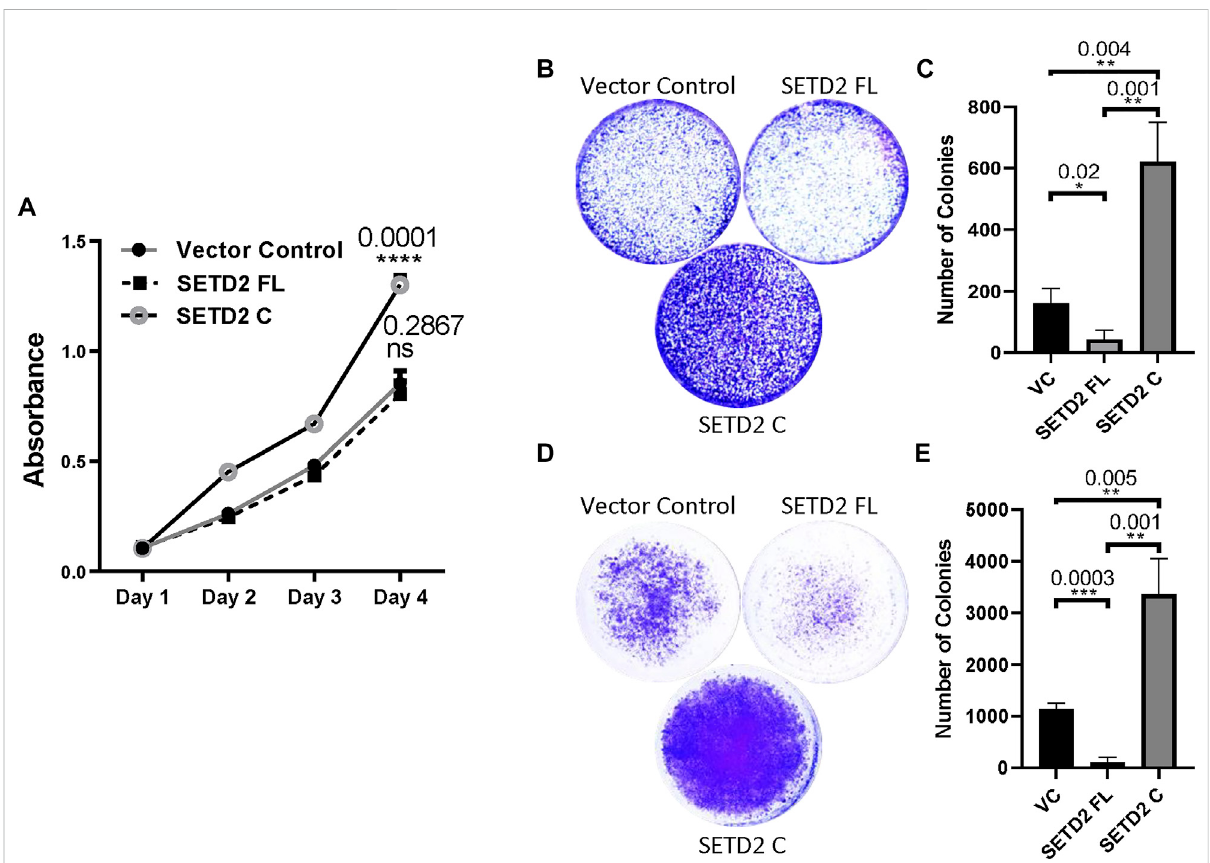
FIGURE 4 SETD2 accumulation results in cancer-related phenotypes. (A) A plot showing the results of the MTT assay to check cell proliferation. n = 3 independent biological samples examined in 3 independent experiments. ANOVA (2-way) was performed. p -value < 0.05 was considered signi fi cant. (B – E) Crystal violet-stained plates of invasion and migration assays were performed using KO cells expressing GFP-SETD2 FL and SETD2 C along with the associated quanti fi cation. n = 3 independent biological samples examined in 3 independent experiments. An unpaired t -test (two-tailed) was performed. p -value < 0.05 was considered signi fi cant. Data are presented as mean values with a Standard Error of